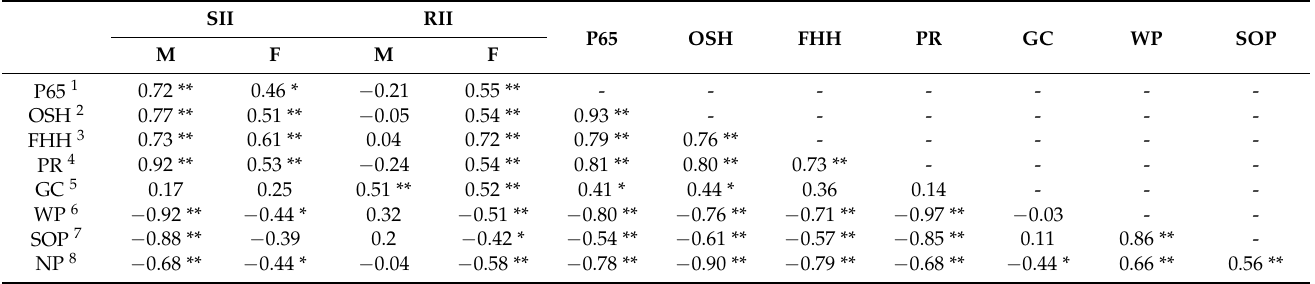
Table 4. Pearson correlation coefficients for SII, RII, demographic factors, and socio-economic factors across 25 districts in Seoul.